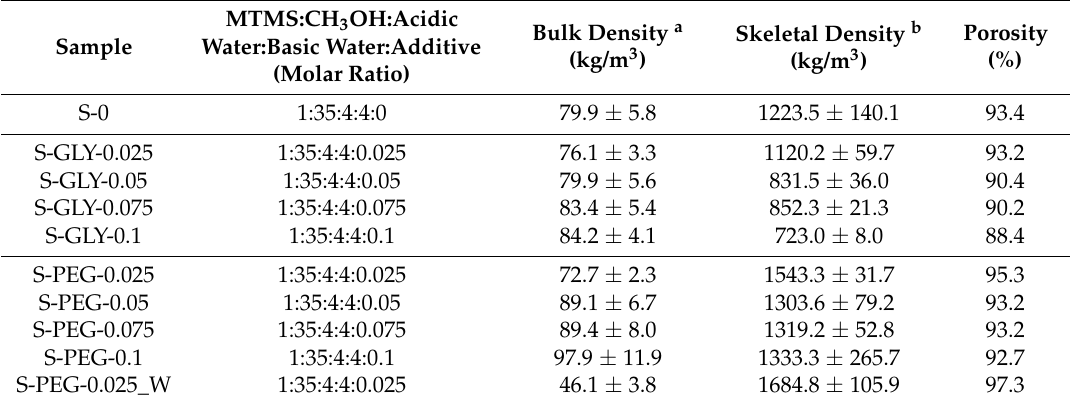
Table 2. Samples identification and the molar ratios used for each aerogel-like material, as well as the corresponding densities and